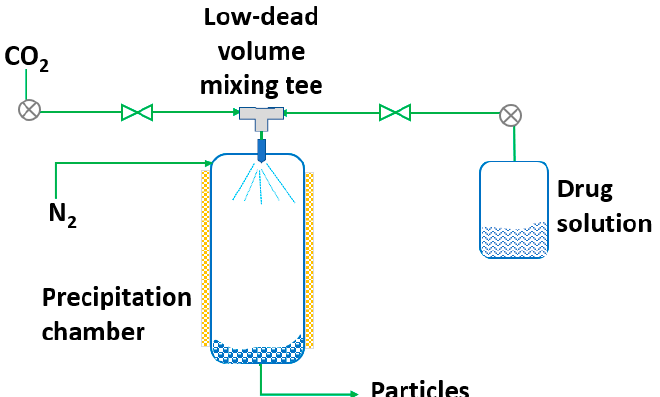
Figure 8. CO 2 -Assisted Nebulization with a Bubble Dryer (CAN-BD) process (adapted from Costa et al. [137]).